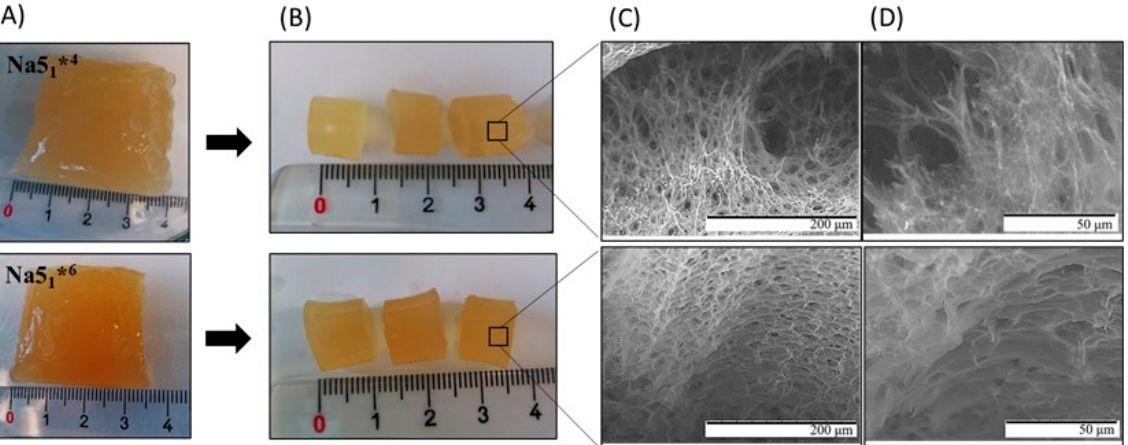
Figure 1. Na5 1 * 4 and Na5 1 * 6 hydrogels: ( A ) immediately after dialysis, ( B ) after being cut with cylindrical mold, and ( C , D ) SEM images of the hydrogels. Hydrogel regions observed under 1500× magnification ( D ) were expanded from images presented under 500× magnification ( C ).